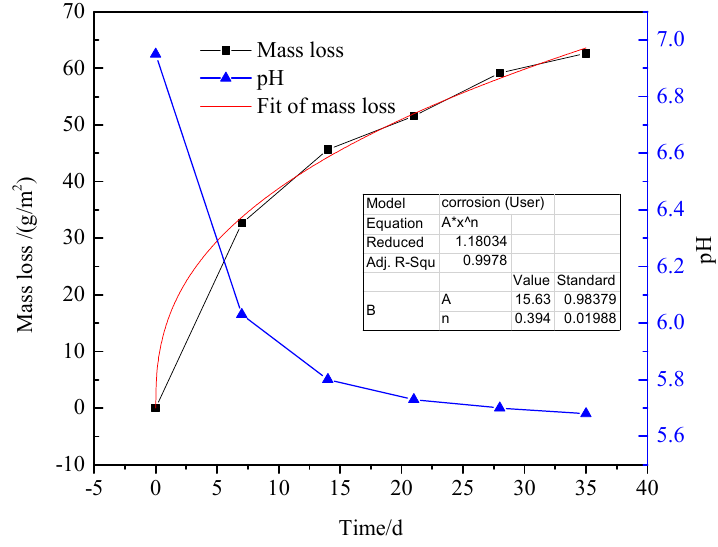
Figure 3. Curve of mass loss and pH with time of Q235B steel in desulfurization solution.